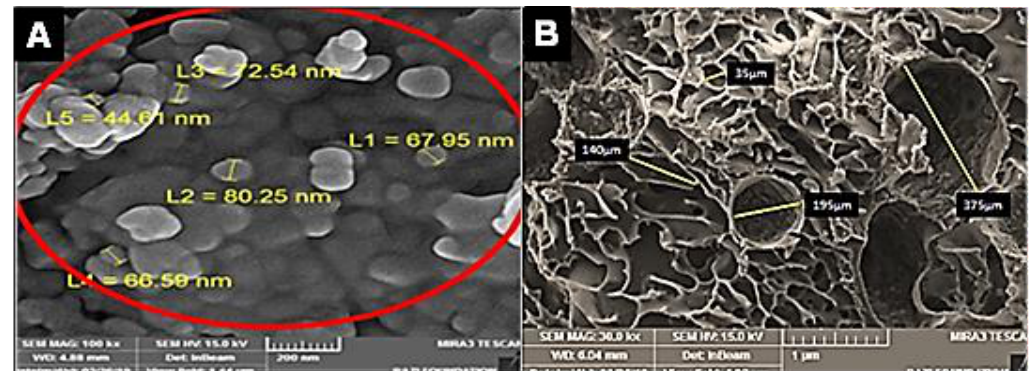
Figure 3. SEM microphotographs of Nano scaffolds prepared by heated method the magnification bars correspond to 1 µm (A) show the particles of Crab shell after ground contains principle material as CaCO show porous structure with pore sizes ranging from 30 to 400